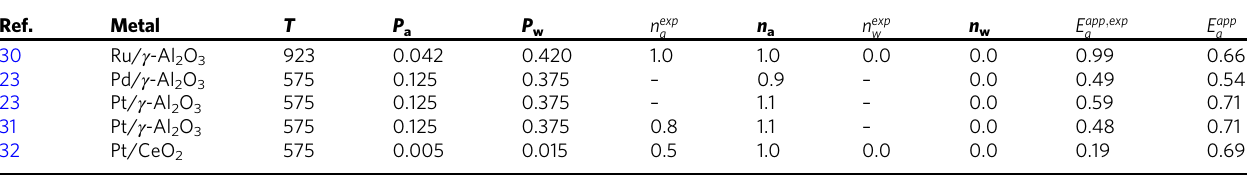
Table 1 Comparison between theory and experiments for ethanol SR